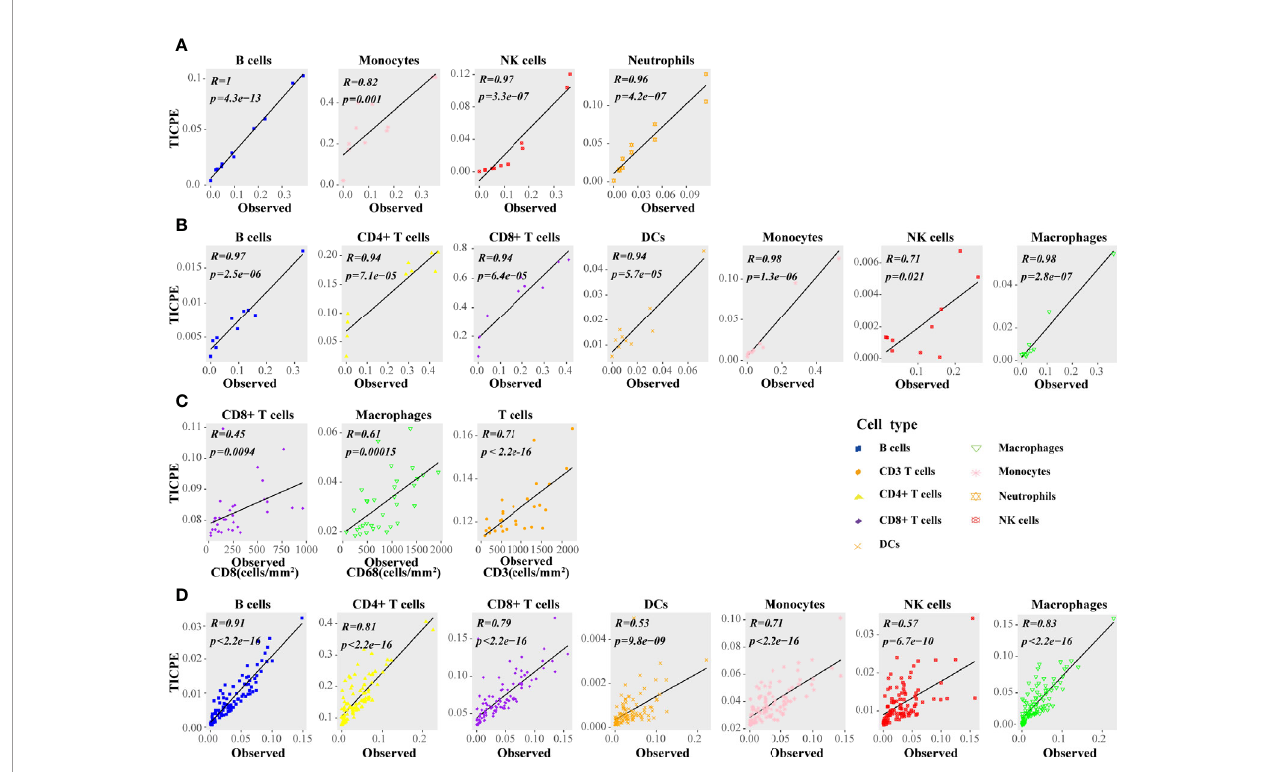
FIGURE 2 | Performance assessment of the TICPE in solid tumors. (A) Correlation of the TICPE predictions with the cell proportions for the populations introduced in the mixtures. (B) Comparison with single-cell RNA-Seq data from colon samples. (C) Correlation of the TICPE predictions with corresponding cell densities measured by immunohistochemistry from colon cancer primary tumors. (D) Correlation of the TICPE predictions versus known cell type fractions on 100 simulated bulk samples generated from scRNA-seq from colon samples. Correlations were based on Pearson correlation. Proportions of cells observed experimentally were given in Supplementary Table 2